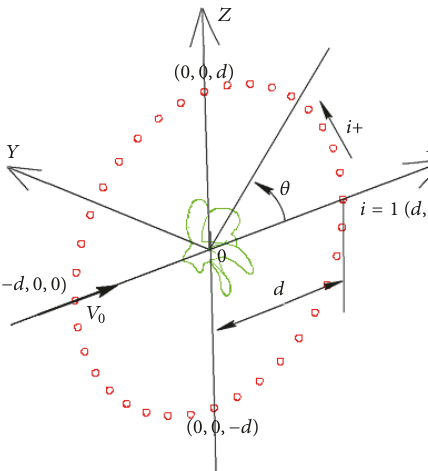
Figure 18: Schematic of calculation positions.